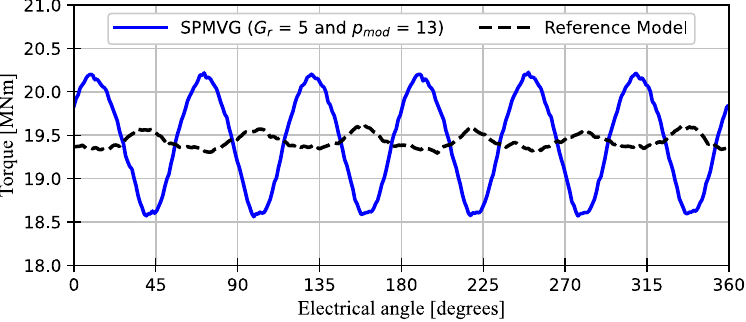
Figure 12. Flux density distribution at rated conditions ( a ) reference model, ( b ) designed SPMVG.